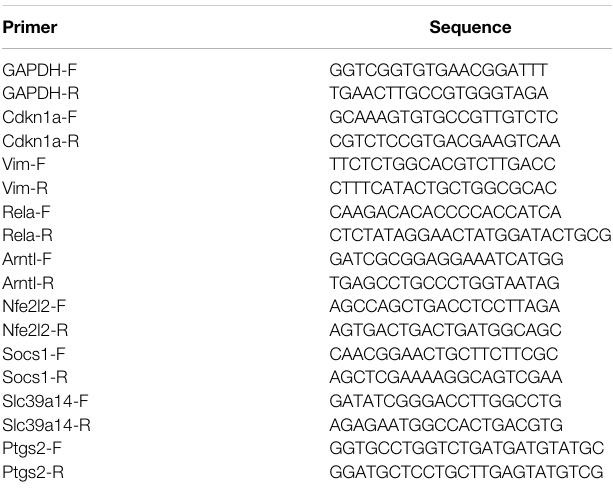
TABLE 1 | The primer sequences of hub